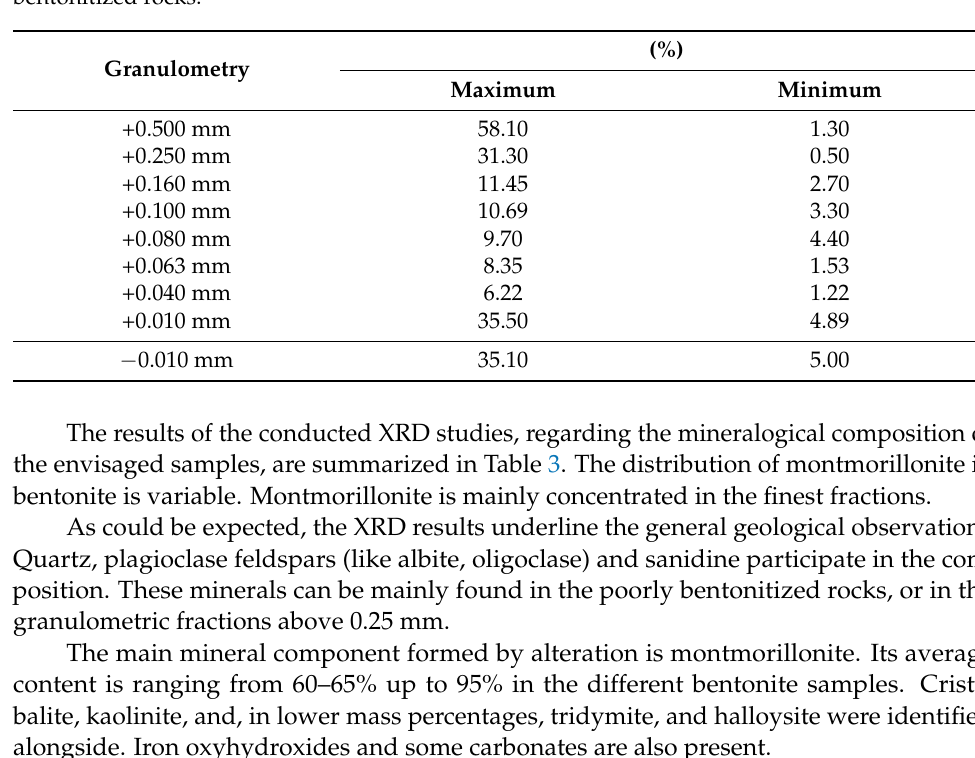
Table 2. Maximum and minimum mass percentages of the granulometric fractions of bentonites and bentonitized